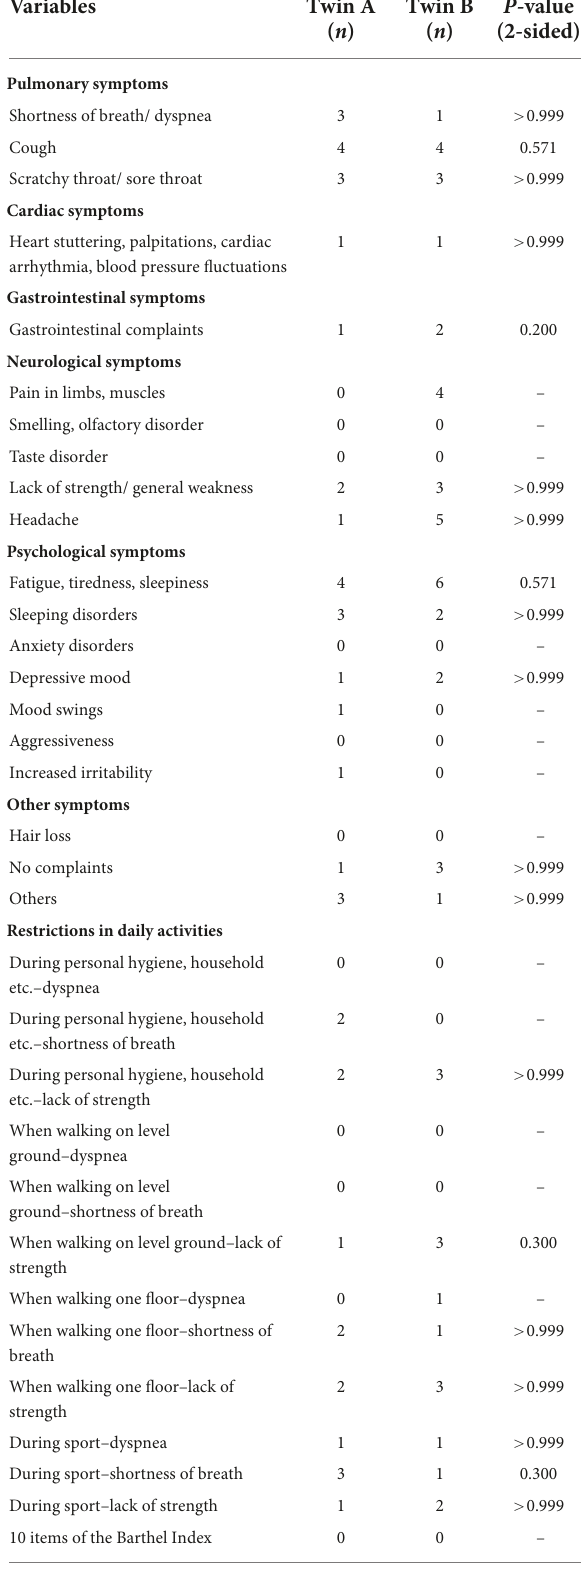
TABLE 1 Demographics and baseline characteristics of the study population.